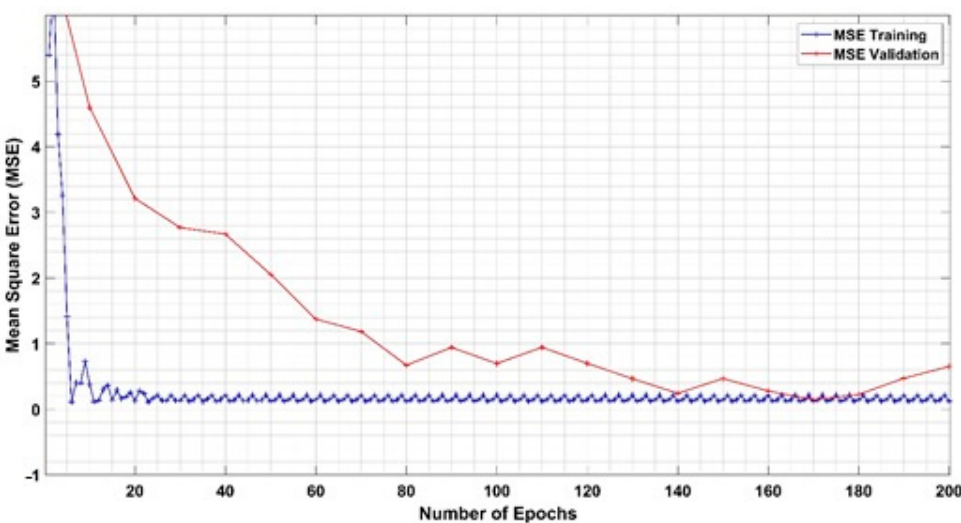
Figure 8. Overall mean square error for network training.